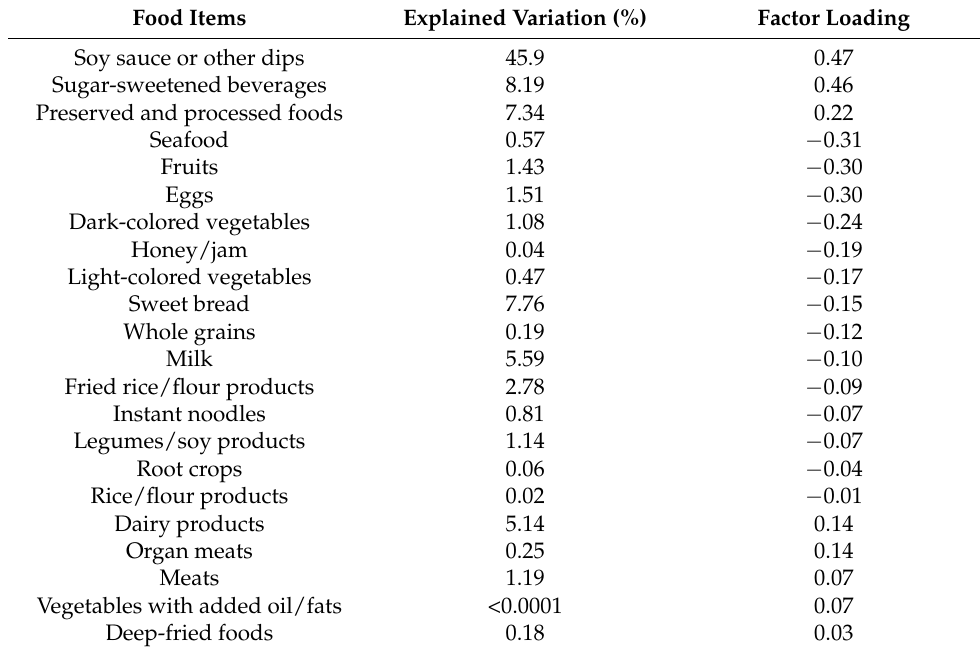
Table 3. Percentage of variation explained by liver-associated dietary patterns and factor loadings of 22 food items by reduced rank regression